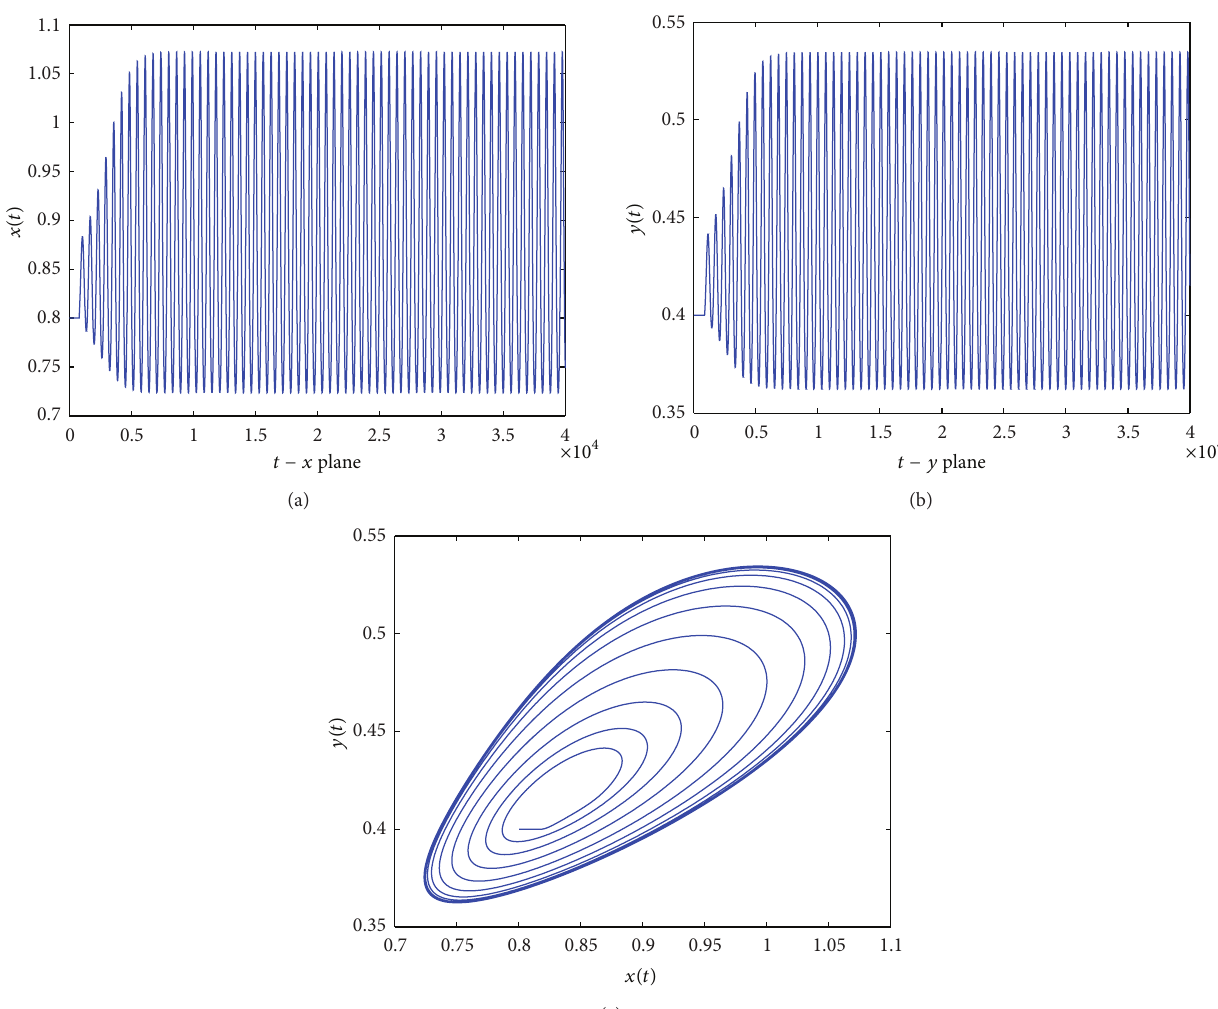
Figure 3: The trajectories and phase graphs of system (1) with 𝜏 = 𝜏 1 + 𝜏 2 = 6 + 6 = 12